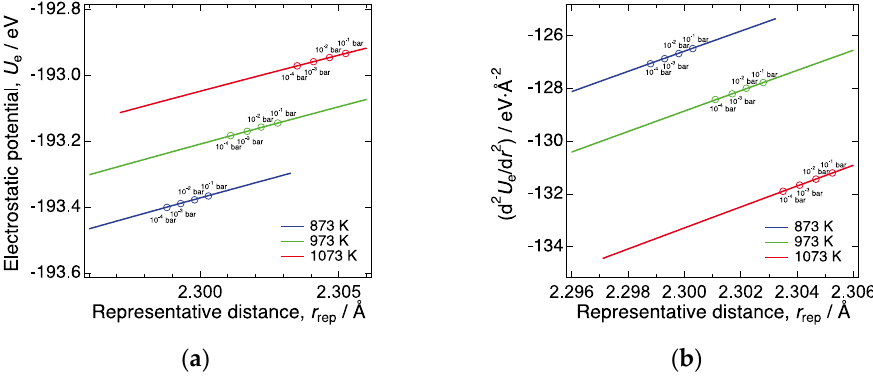
Figure 5. ( a ) Electrostatic potential of LN214 as a function of the representative distance at 873, 973, and 1073 K, under the assumption that a - and c -lattice constants decrease/increase with increasing P (O 2 ), respectively, while the interstitial oxygen concentration remains unchanged. We linearly interpolated the P (O 2 ) dependence of a and c of LN214 [24] and calculated the electrostatic potentials at each lattice constant by the Ewald summation technique, assuming the crystal structure of LN214 was tetragonal (I4/mmm). ( b ) Second derivative of the electrostatic potential of LN214 at 873, 973, and 1073 K, which was numerically calculated using the data shown in Figure 4a.